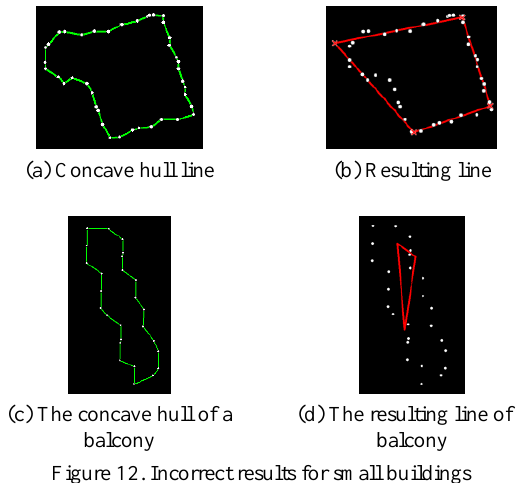
Figure 12. Incorrect results for small